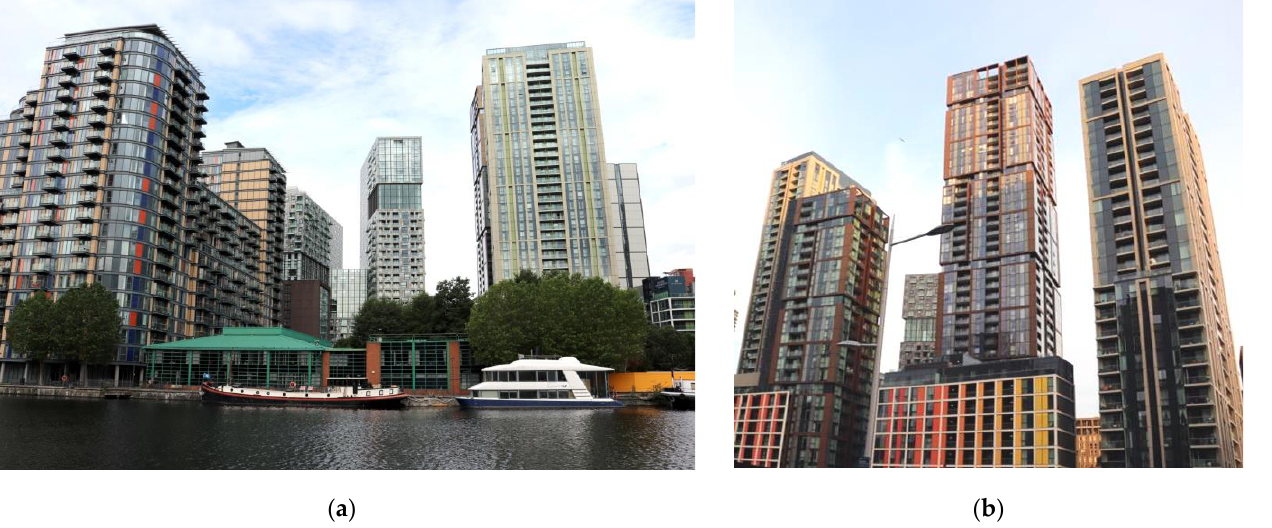
Figure 13. Examples of colour and domestic detailing in residential towers, ( a ) pixelated Franklin Tower in the centre, Sirocco Tower to the right and Ability Place (not included in the study) to the left; ( b ) Harbour Central estate, from left: Sirocco, Ostro, Maine, Salvor towers, Franklin Tower in the background (2021).